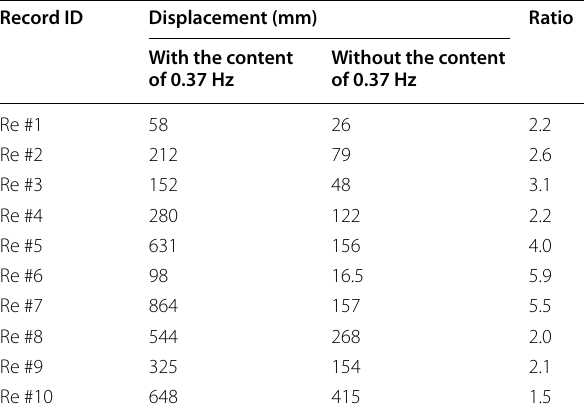
Table 2 Displacement reduction ratio w/o a frequency content 0.37 Hz.